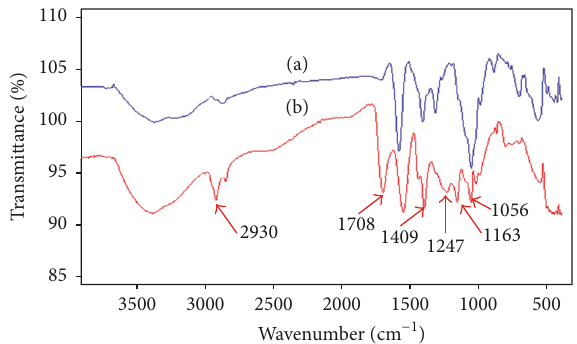
Figure 1: ATR-FTIR spectra of (a) NaCMC and (b) NaCMC-g-PAA superabsorbent polymer.